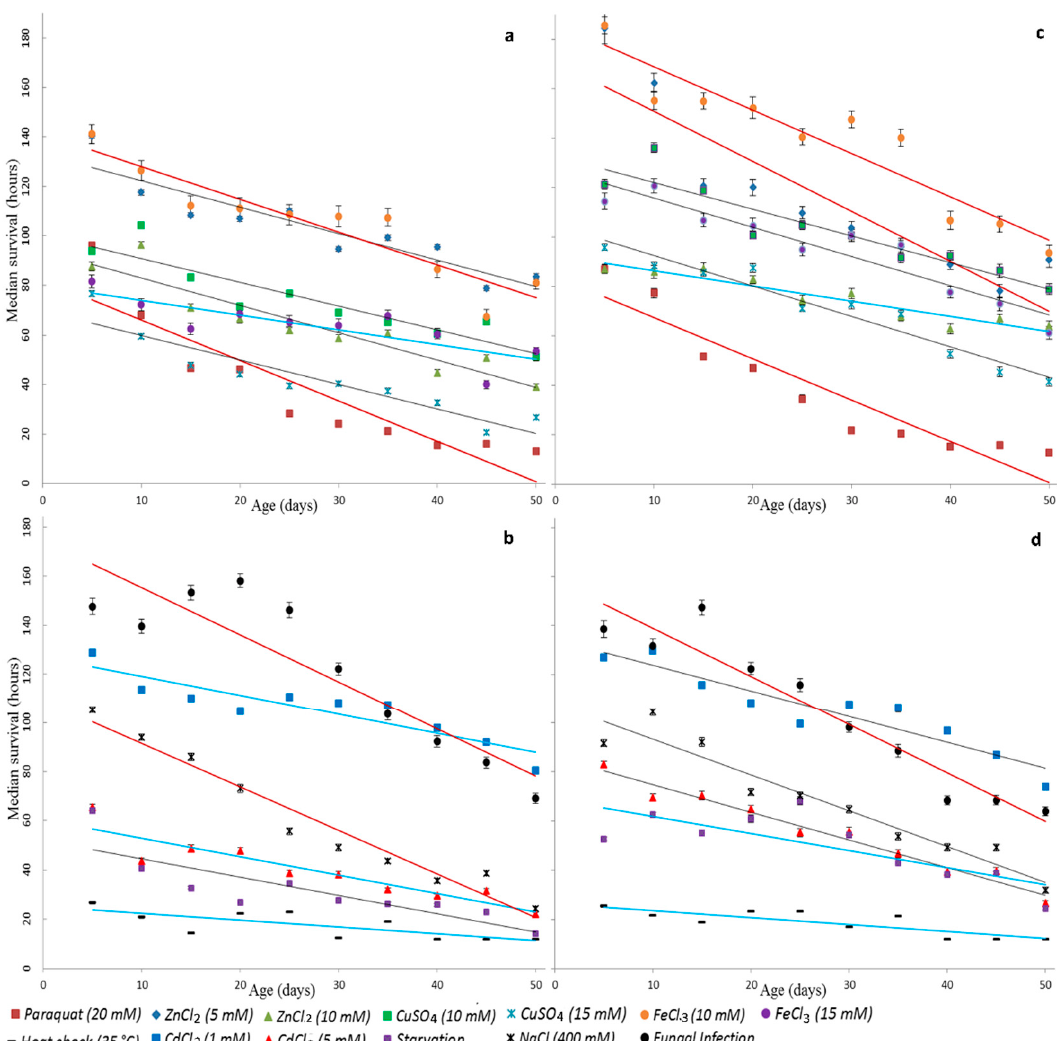
Figure 2. The relationship between the median survival time and the age of flies under the following stress conditions: oxidative and genotoxic stress (( a )—male, ( c )—female), proteotoxic, osmotic stress, starvation, and response to infection (( b )—male, ( d )—females). The lines mark linear regression: red lines show a strong change in survival, gray—middle, blue—slight.